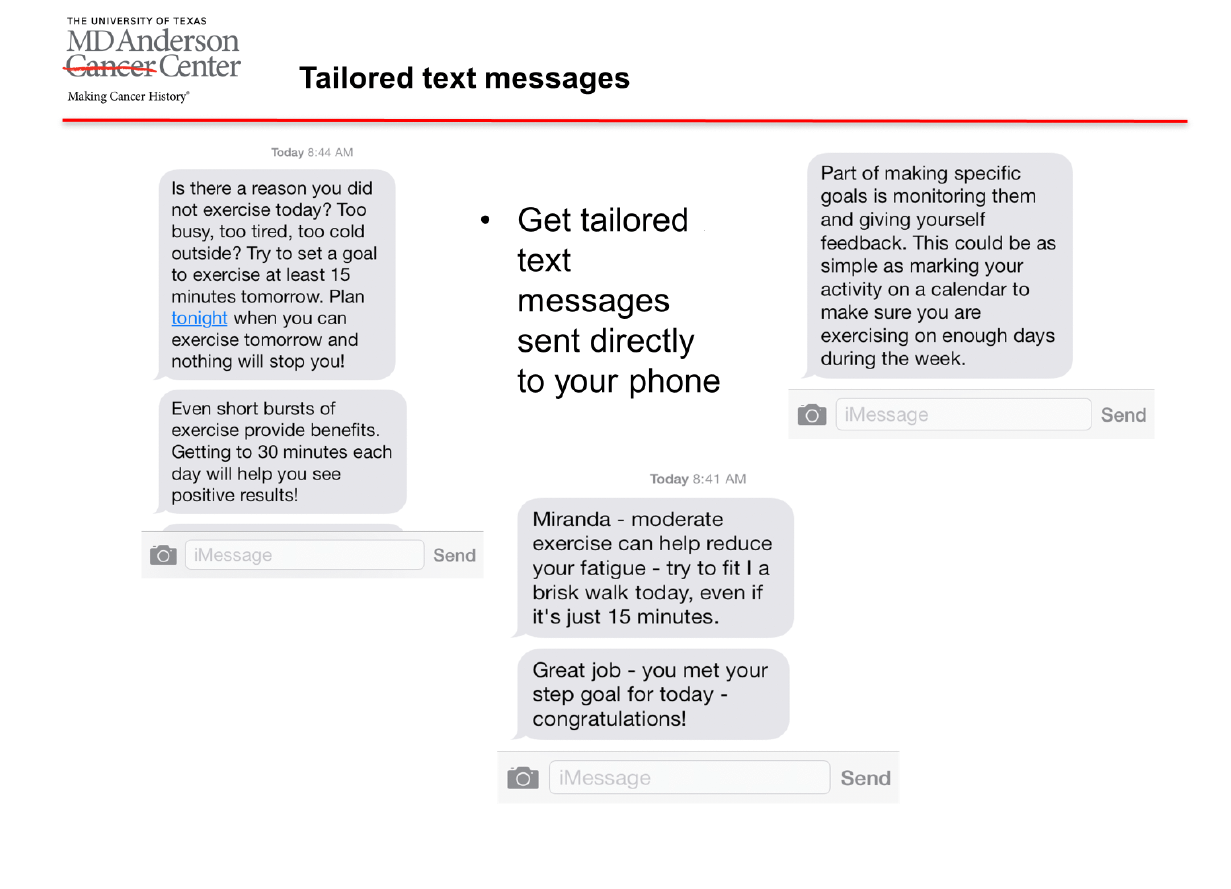
Figure 1. Example of a presented app feature: sending tailored text